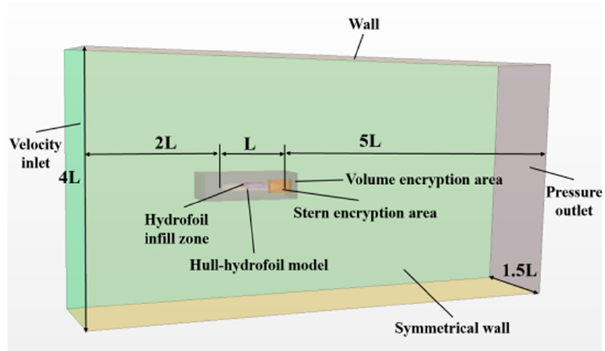
Figure 3. Numerical tank with the boundary conditions.